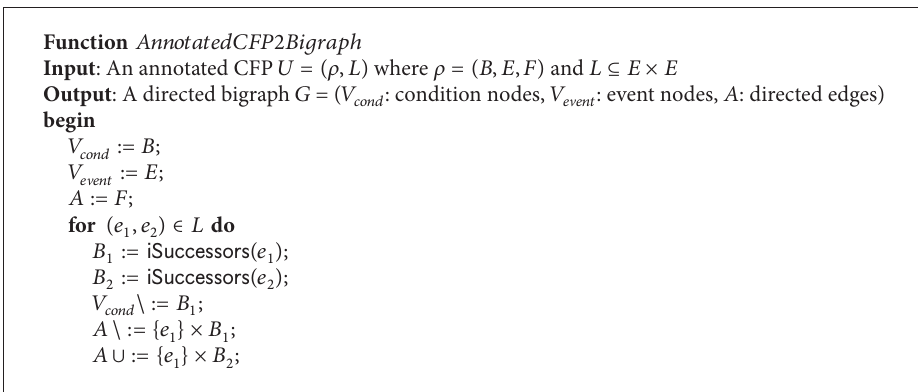
Algorithm 5: Converting an annotated CFP to a directed